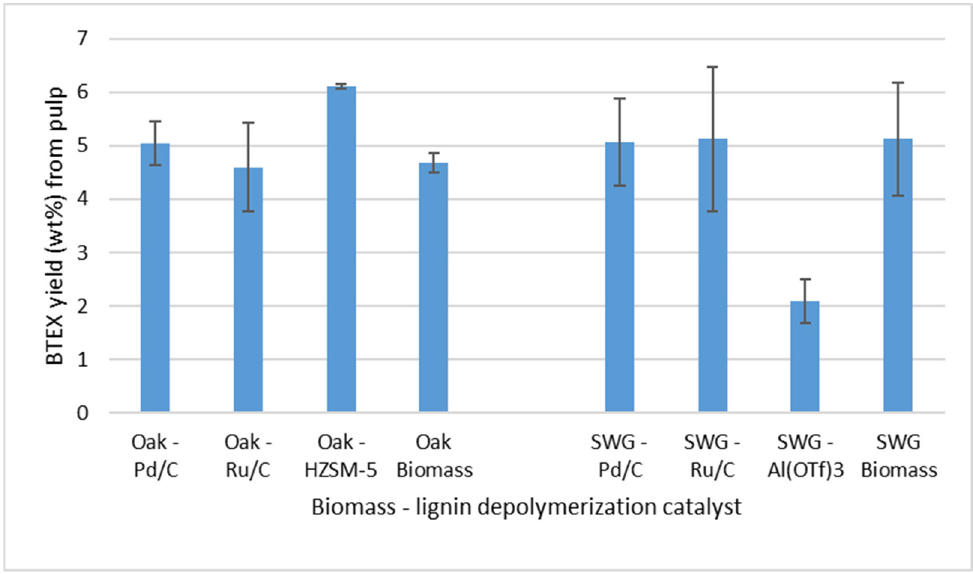
Figure 6. BTEX yield (wt %) from HZSM-5-catalyzed pyrolysis of cellulosic pulps isolated after lignin-first fractionation in ethanol at 210 ◦ C. Pyrolysis at 550 ◦ C, catalyst:biomass ratio of 5:1 ( w/w ). Error bars are one standard deviation.